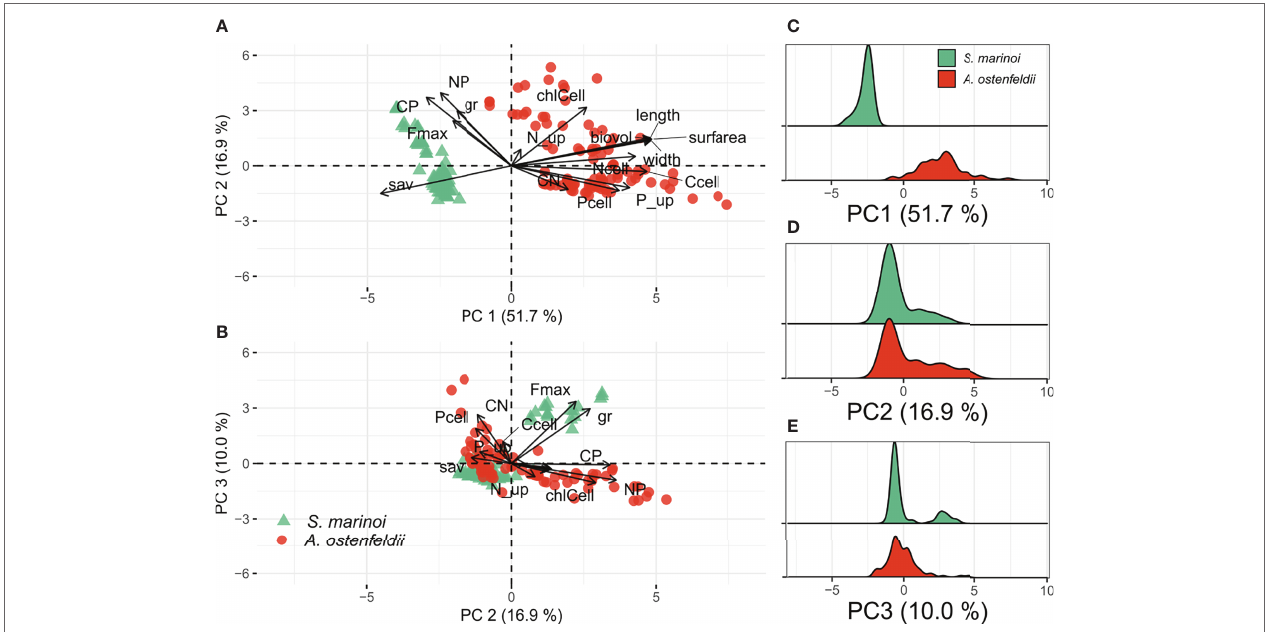
FIGURE 1 | Results of PCA for two species. Ordination plots summarizing traits variation of A. ostenfeldii and S. marinoi strains (A, B) . Density plots of individual loadings grouped by species (C–E) . Traits abbreviations as in Table 1 .